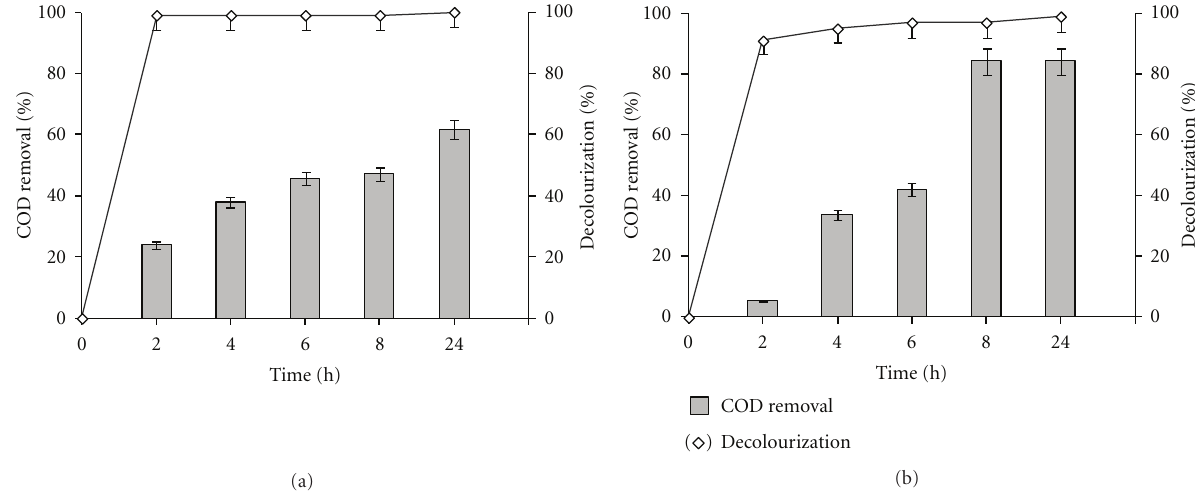
Figure 2: Decolorization and COD removal dyes, crystal violet (a), and malachite green (b), obtained by a consortium CM-4 in MSM medium supplemented with 0.1% yeast extract and 7mM glucose at 35 ◦ C during 24h, under agitation conditions (120rpm).